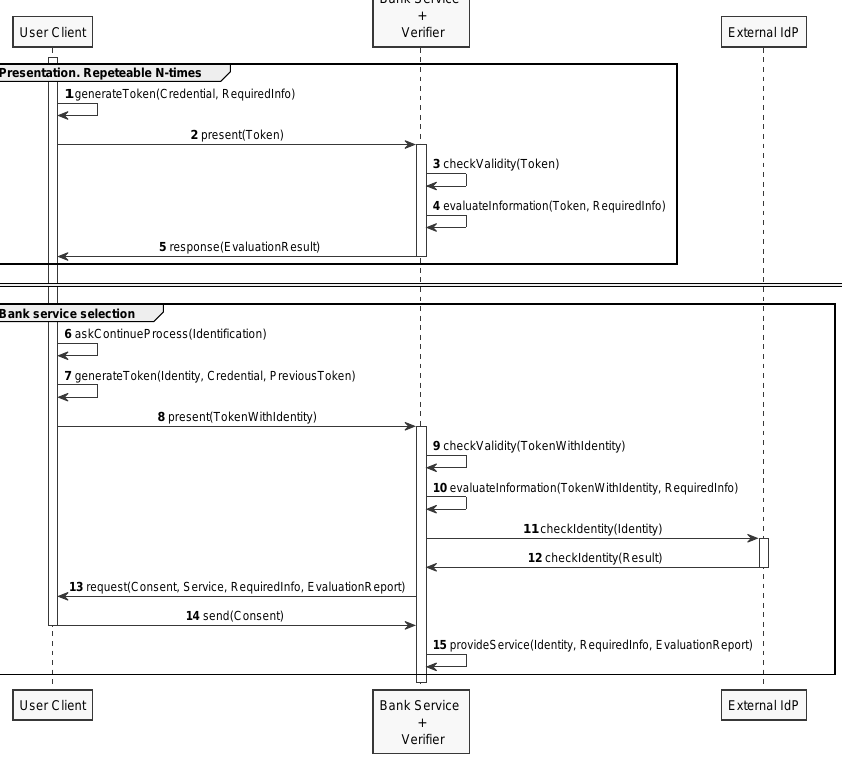
Figure 5. Credit File presentation process with